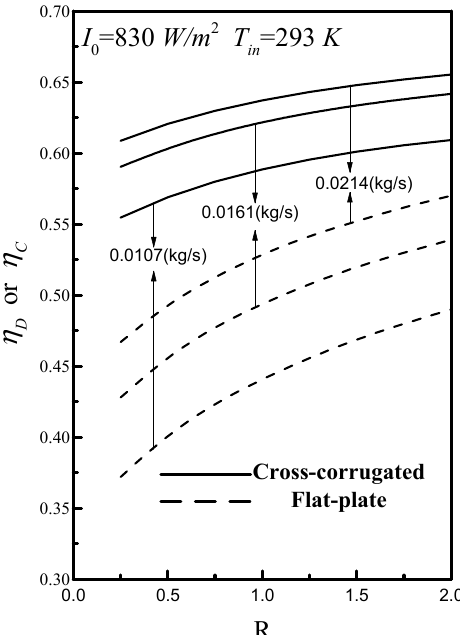
Figure 6. Comparisons of collector efficiencies for both recycling flat-plate and cross-corrugated solar air collectors ( I 0 = 830 W/m 2 ).